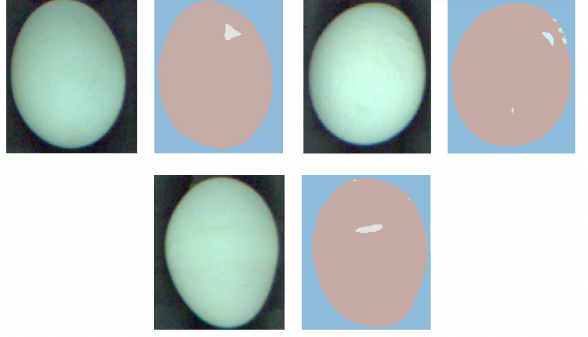
Figure 8. Dirt detection samples using semantic segmentation. On the other hand, the semantic segmentation algorithm achieved high performance in crack detection, with a recall of 99%, outperforming the classical and image classification method by 11% and 9%,